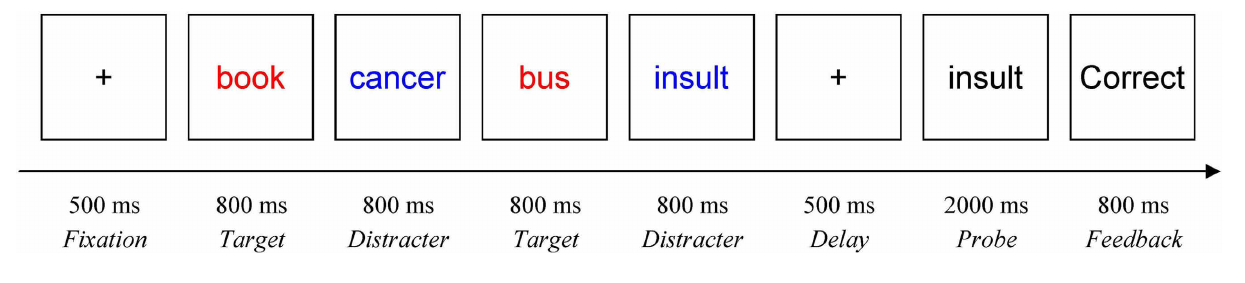
FIGURE 1 | Working memory task procedure (a neuTnegD trial with a negative distracter probe). In this example trial, the participant correctly responded “NO” to the distracter probe and received a feedback screen indicating that the response was